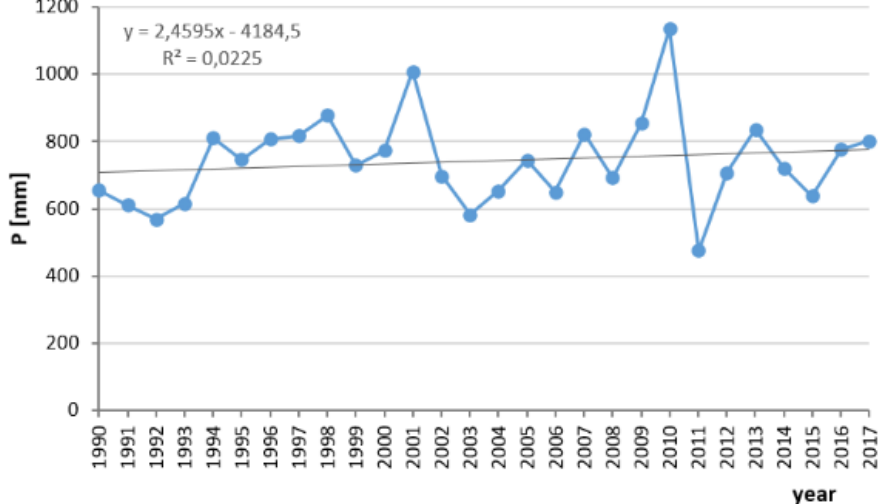
Figure 3. Course of the annual sum of precipitation for the Prądnik river basin in the period 1990– 2017.